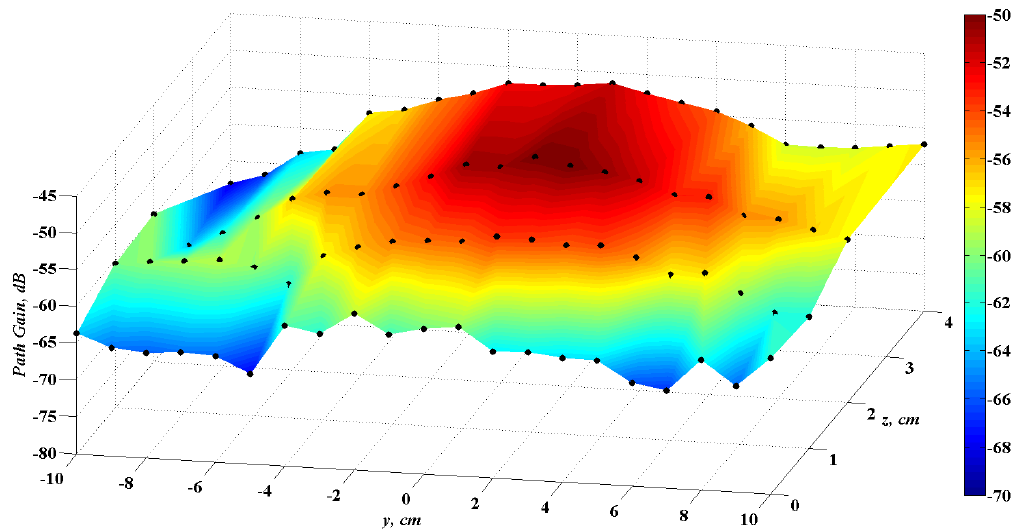
Figure 12. Path gain distribution for: ( a ) rectangular and ( b ) real hand skin-equivalent phantom. Distance between the phantom and waveguide is d = 5